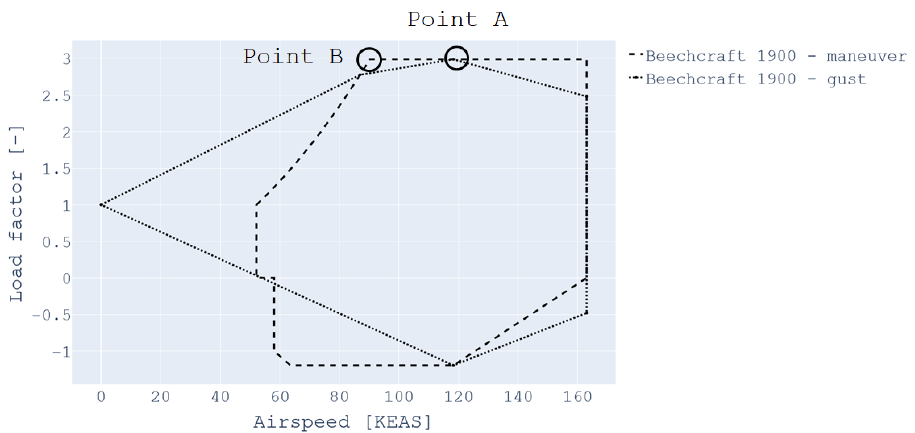
Figure 8. V-n diagram obtained by FAST-OAD-GA for the Beechcraft 1900, a commuter type aircraft.